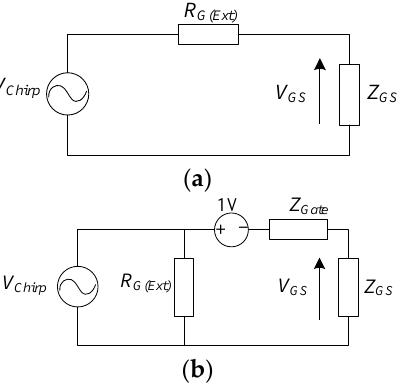
Figure 9. Schematic ( a ) without gate driver; ( b ) with gate driver.